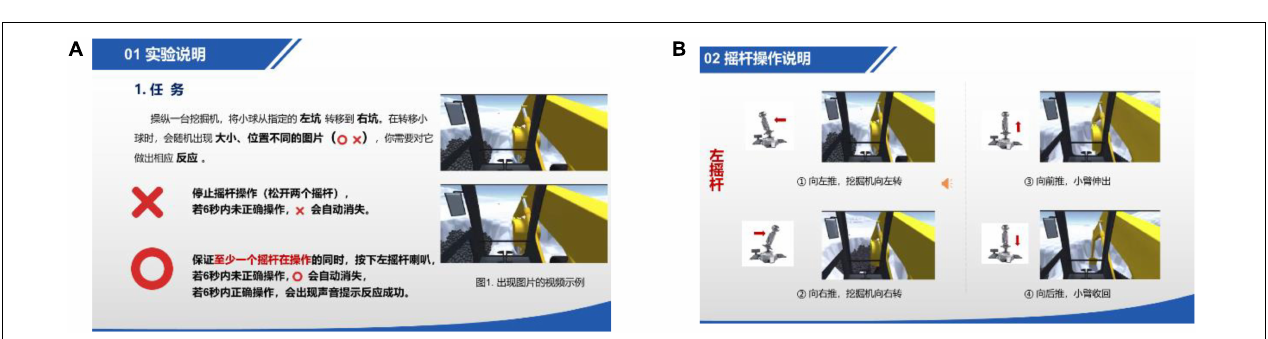
FIGURE 3 | Introduction video